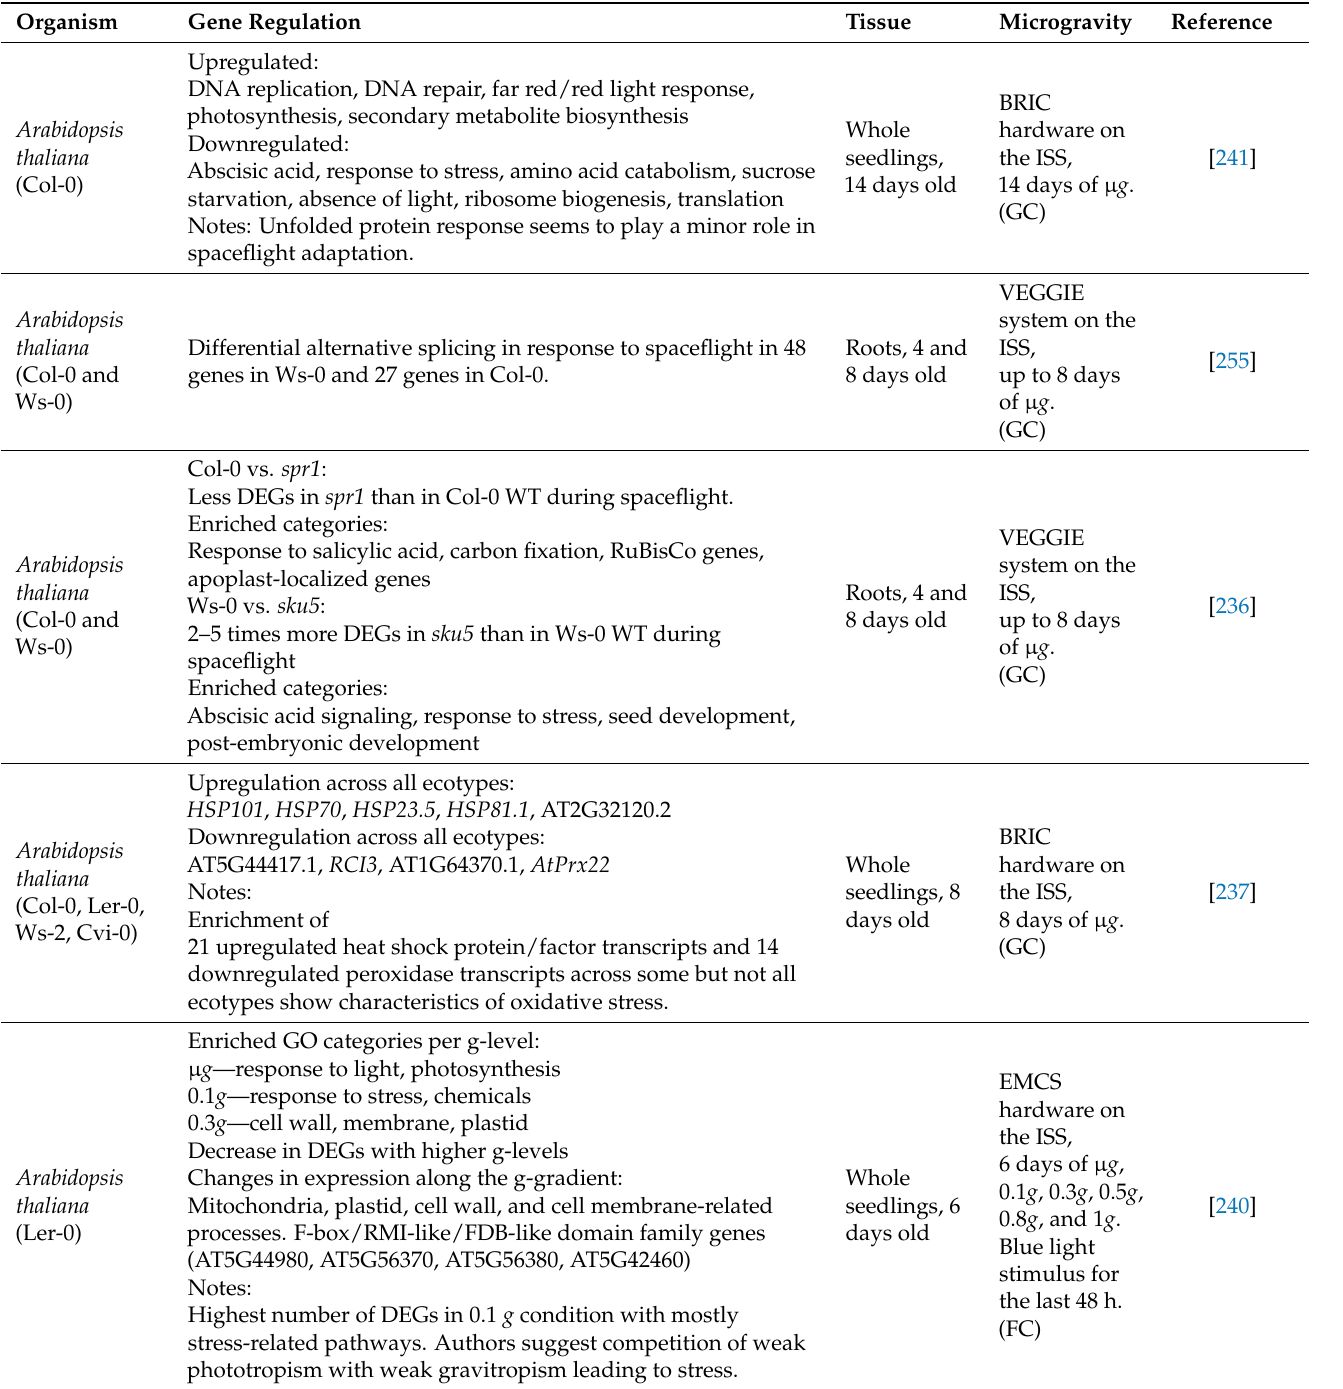
Table 10. Gene expression changes in various plant organisms in response to spaceflight. Use of in-flight controls (FC) or ground-based controls (GC) is